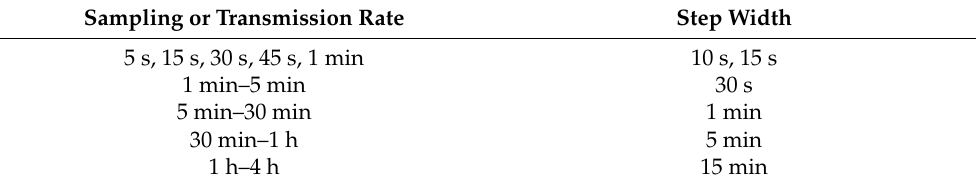
Table 2. Configurations for sampling and data transmission rates with varying step widths.